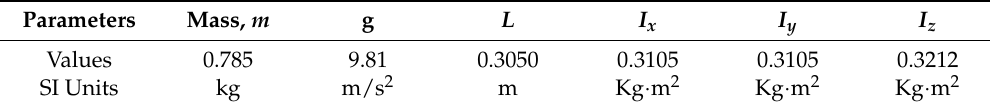
Table 1. Tri-rotor aerial vehicle system parameters.